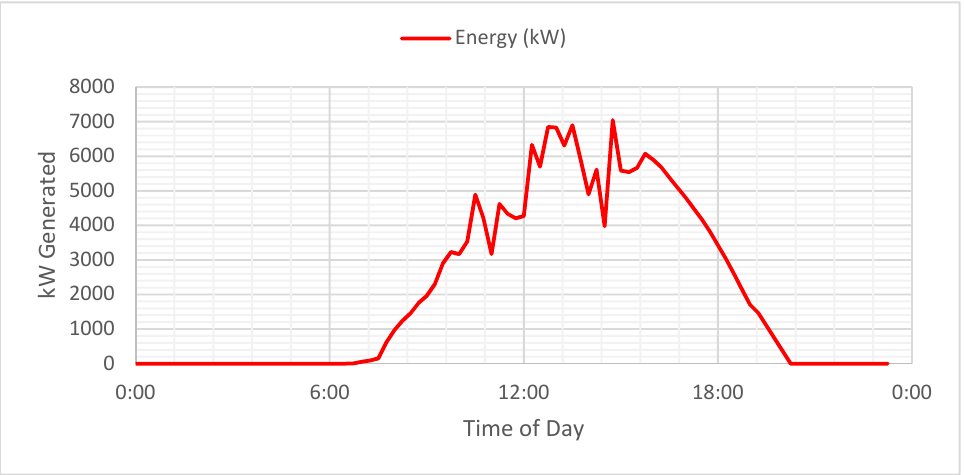
Figure 4. Daily output of Solar Farm One: Winchester, KY on 3 June 2022 [15].